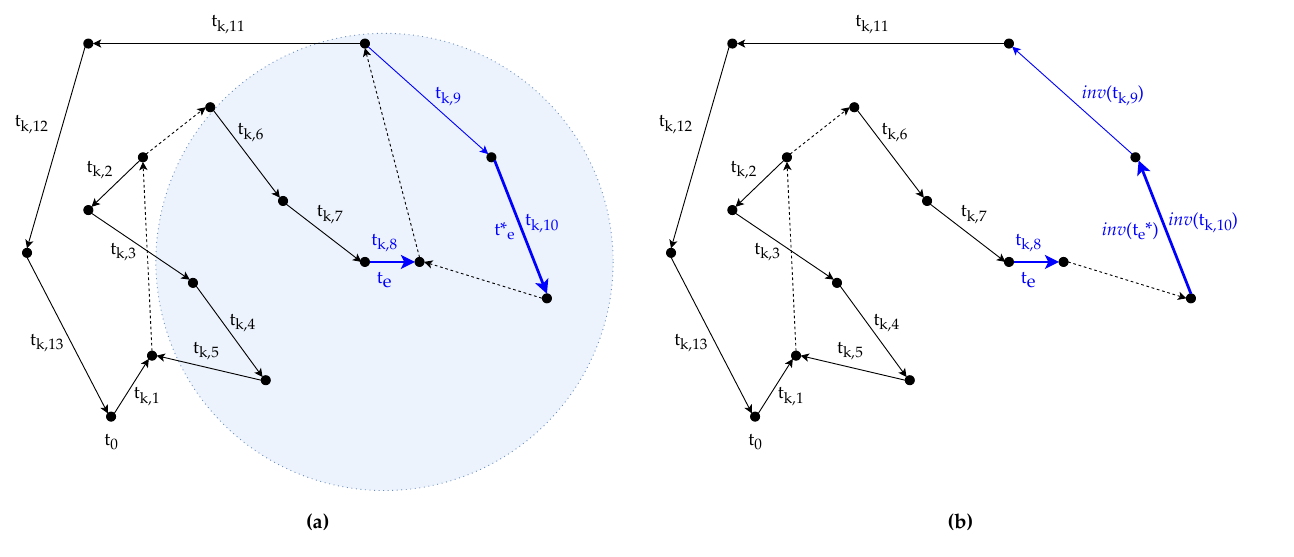
Figure 6. Rotation of the sub-route plan enclosed by t k , e and t k , e ∗ : ( a ) An arc task ( t k ,10 ) is randomly selected as t k , e ∗ from the neighbor list of arc task t k , e ( t k ,8 ), thus, a sub-route plan is obtained; ( b ) The sub-route plan is inverted, so t k , e will be directly followed by inv ( t k , e ∗ ) in the new route plan r (cid:48)